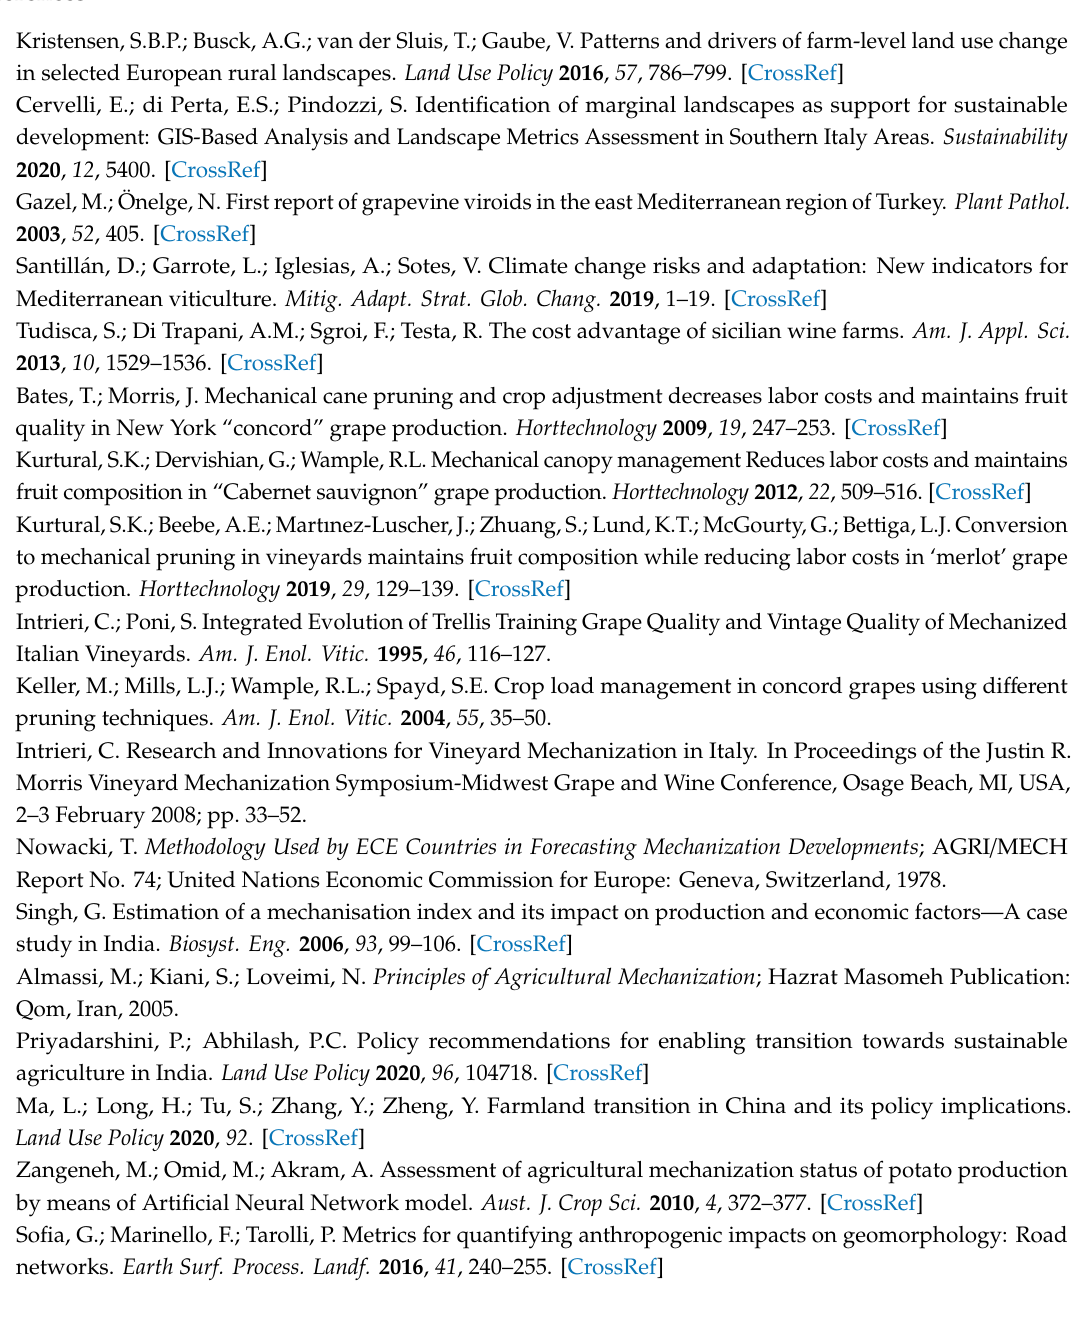
Figure S1: Tendone training system, Figure S2: Pergola training system, Table S1: Summary table of the average parameters for every